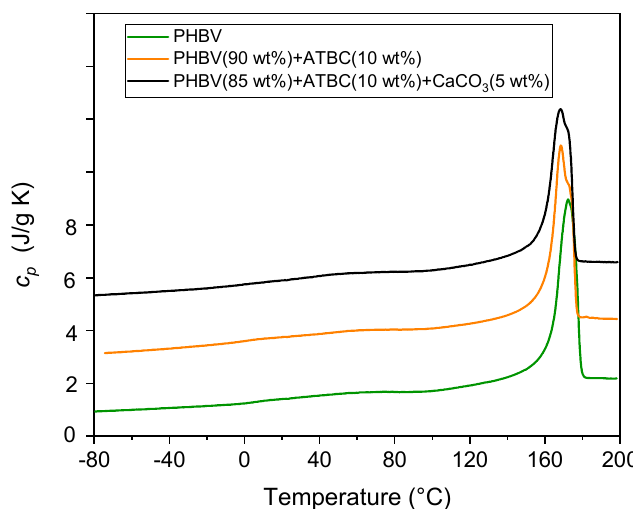
PP - 1000x PP-1200x PP-2000x Figure 2. SEM images of the PP powder at the magnifications indicated. 3.3. Thermal, mechanical and viscoelastic properties of the PHBV matrix